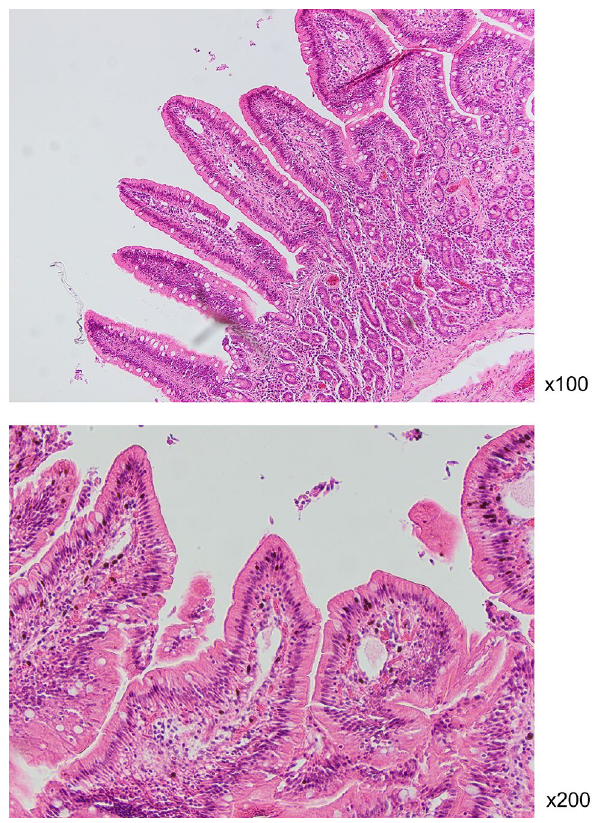
Figure 4. Representative images of hematoxylin and eosin staining of small intestine samples. There were no pathological abnormalities in the small intestine of wild boars in